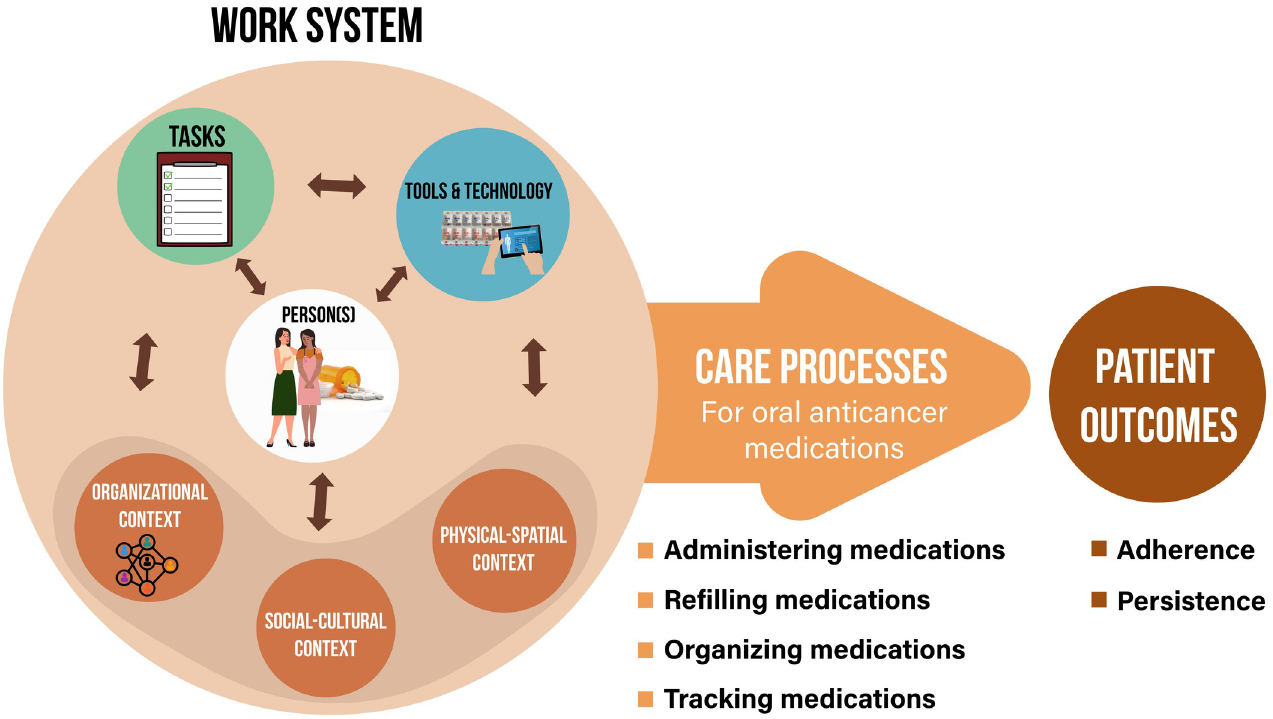
Fig 1. Adaptation of the patient work system model [20] for oral anticancer medication